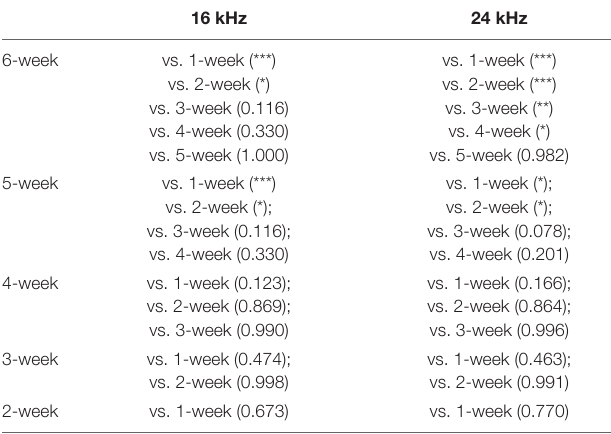
TABLE 4 | Statistical analysis of distortion-product otoacoustic emission (DPOAE) threshold shifts of the 5-aza